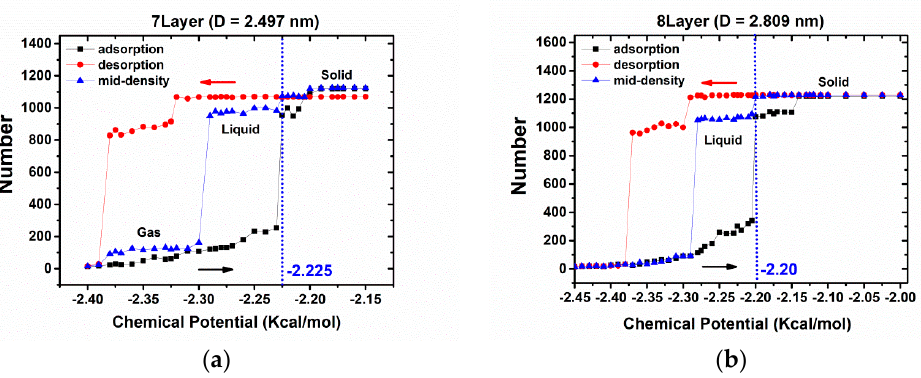
Figure 3. Grand canonical Monte Carlo/molecular dynamics (GCMC/MD) simulations of adsorption (black) and desorption (red) isotherms for argon molecules confined between two commensurate contacts at 85 K at ( a ) n = 7 monolayer and ( b ) n = 8 monolayer thickness. The equilibrium states obtained by the mid-density scheme are shown in blue curves, on which the vertical dashed lines mark the phase boundary between liquid phase and solid phase.